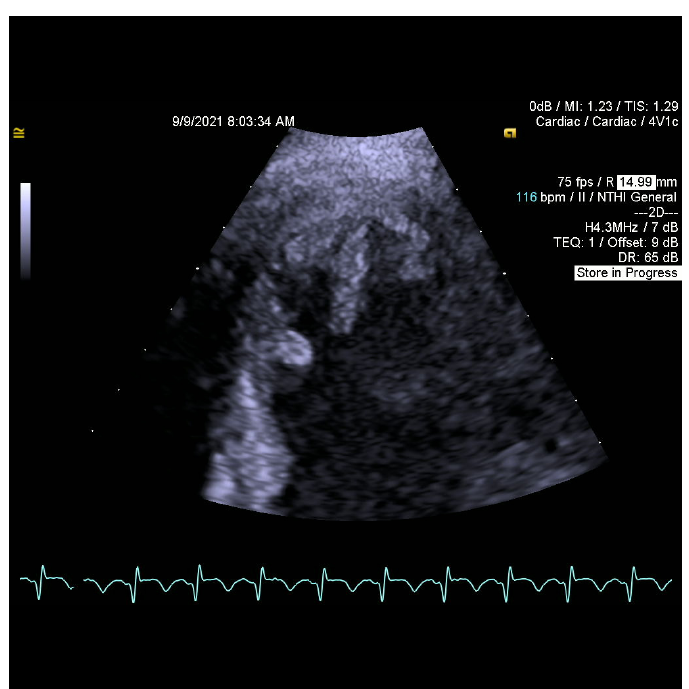
Figure 2. Another focus on thrombi in the left ventricular apex by TTE.